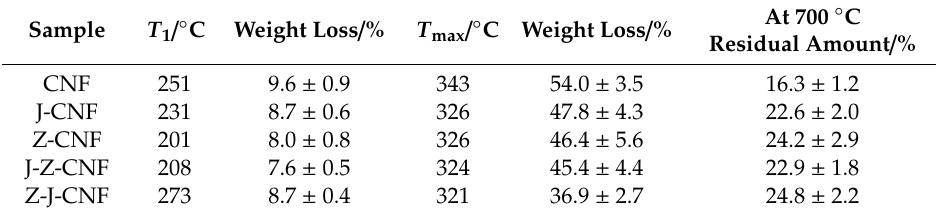
Table 3. Degradation temperatures and weight loss of the CNF and modified CNF based on derivative thermogravimetric (DTG)